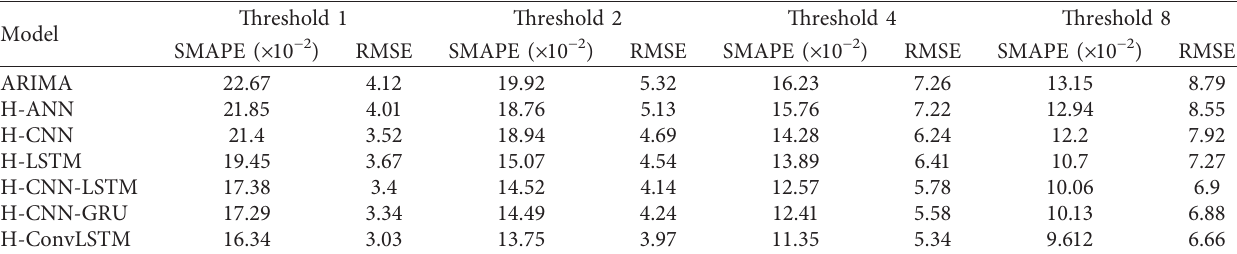
Table 2: Comparison of different models in minimum demand threshold type 1.